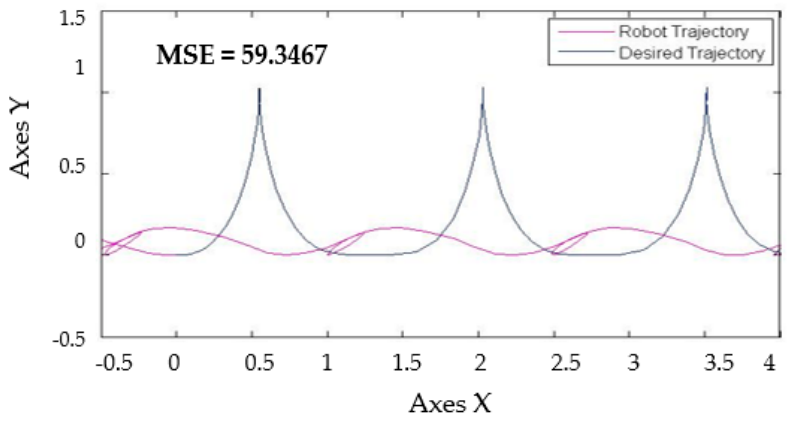
Figure 16. Trajectory in the autonomous mobile robot controller with base FLS with perturbation in the model.